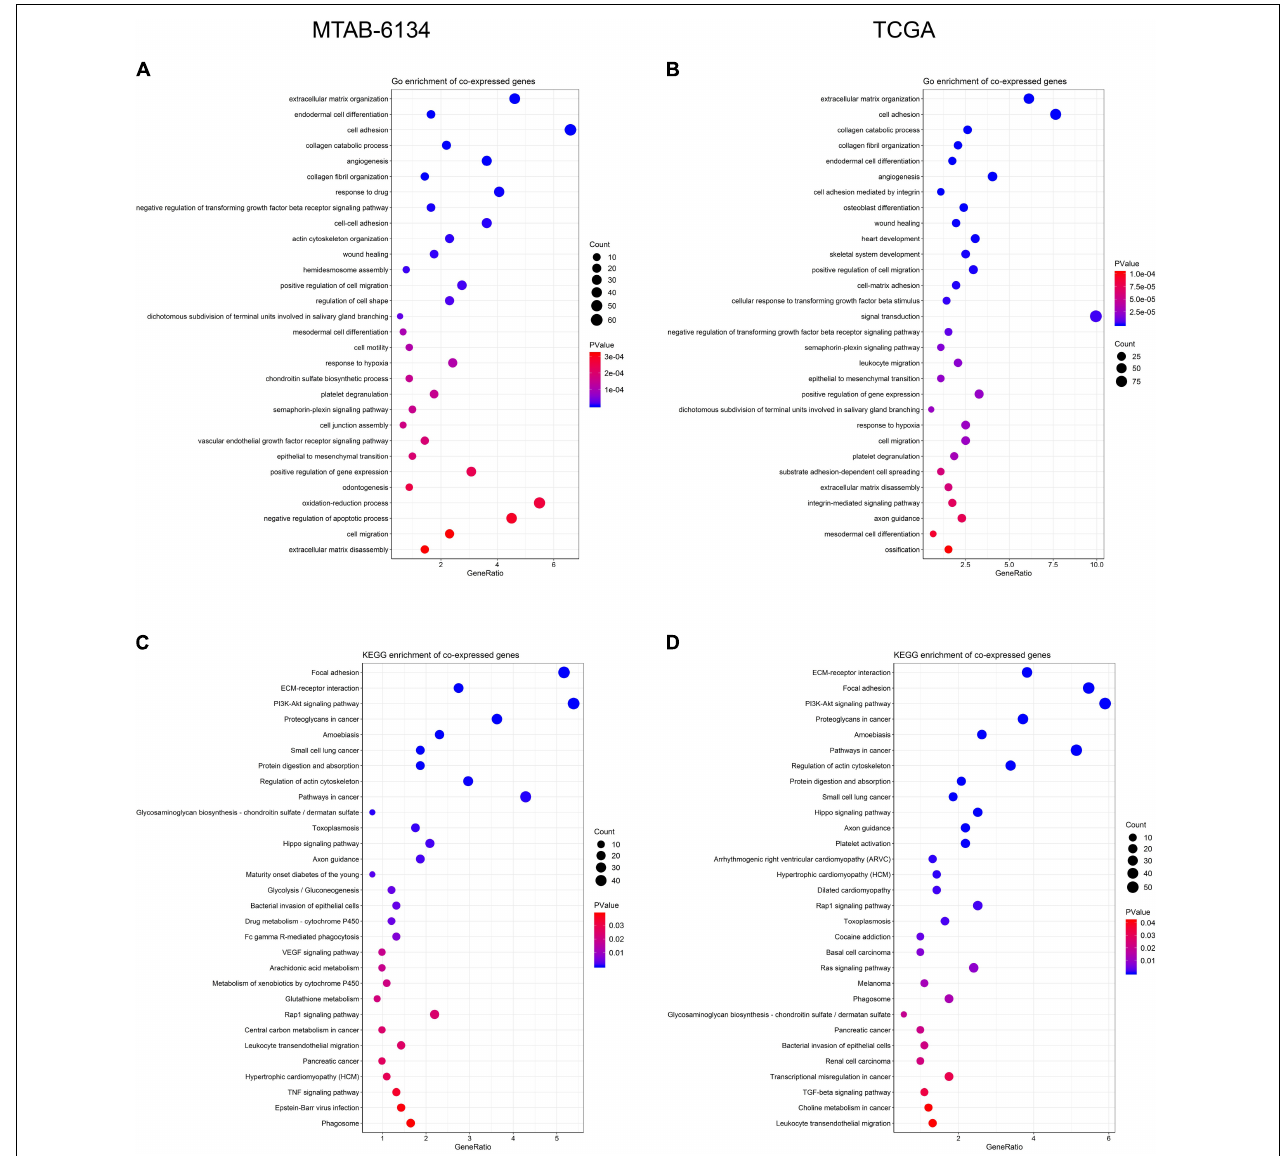
FIGURE 7 | Biological function of DCBLD2. (A,B) Biological process analysis of top 1,000 positively co-expressed genes of DCBLD2. (C,D) KEGG pathway enrichment analysis of top 1,000 positively co-expressed genes of